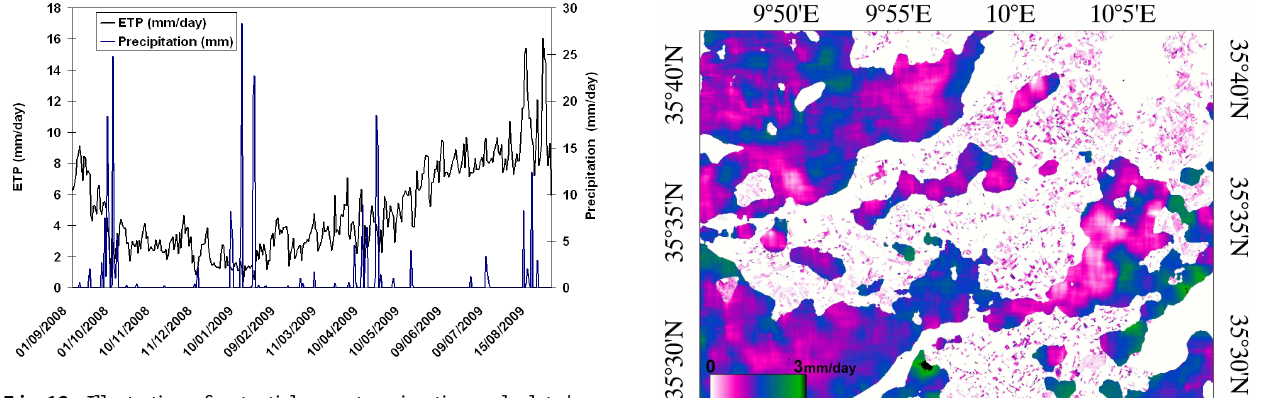
Fig. 12. Illustration of potential evapotransipration, calculated us- ing Pennaman Monteith equation, during the agricultural season 2008–2009.